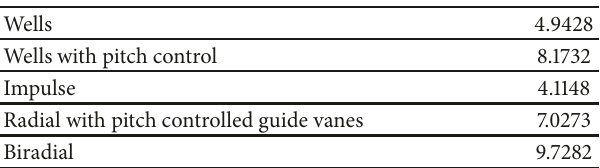
Table 5: Output torque mean